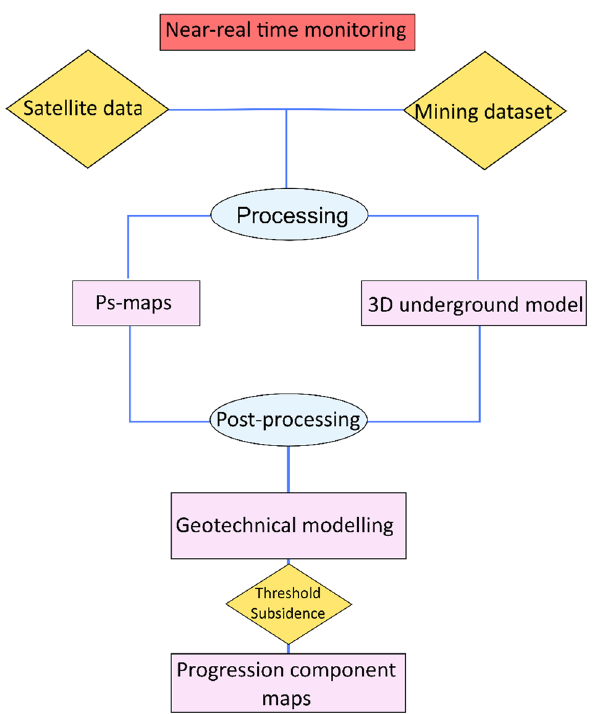
Fig. 3 Flow chart of the methodological approach